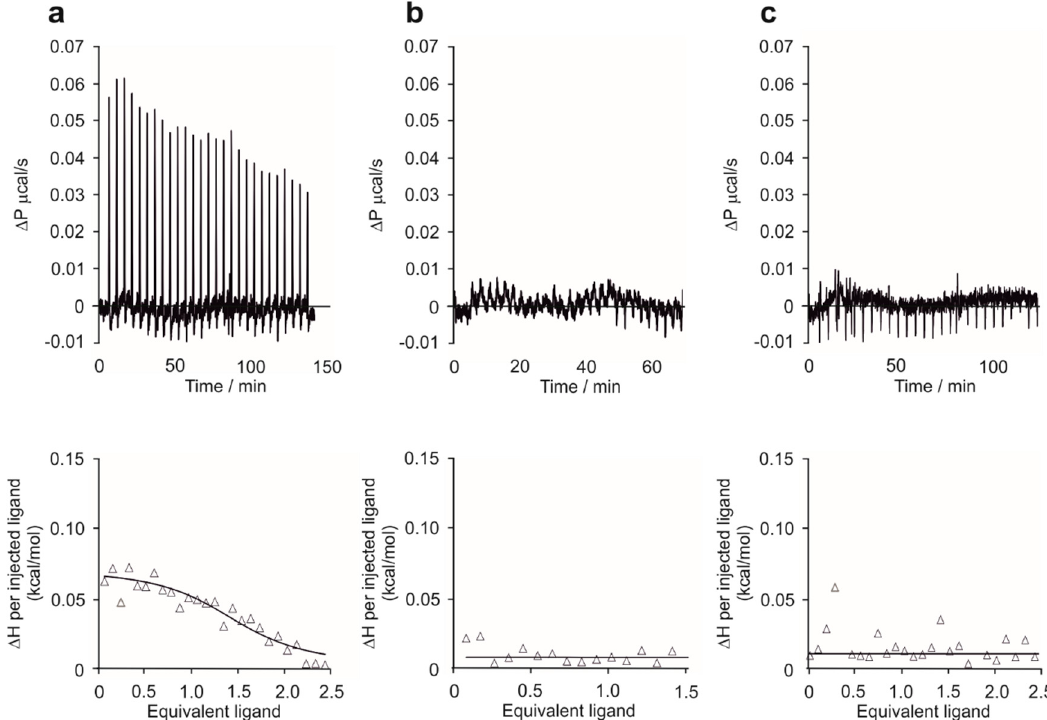
Figure 3. Isothermal titration calorimetry (ITC) measurements. Raw ITC data (top) and the integrated heat data relative to the molar ratio (bottom) in the interaction of P33 and Fe65-WW ( a ), PPPPP and Fe65 ( b ), and P33 and Pin1 ( c ) in phosphate-buffered saline (PBS) (pH 7.4). ( a ) N = 1.14 ± 0.01, Δ H = 0.082 ± 0.001 kcal ∙ mol − 1 , K d = 4.68 ± 0.04 μ M; ( b ) no binding observed; ( c ) no binding observed. ∆ H = 0.082 ± 0.001 kcal · mol − 1 , K d = 4.68 ± 0.04 µ M; ( b ) no binding observed; ( c ) no binding